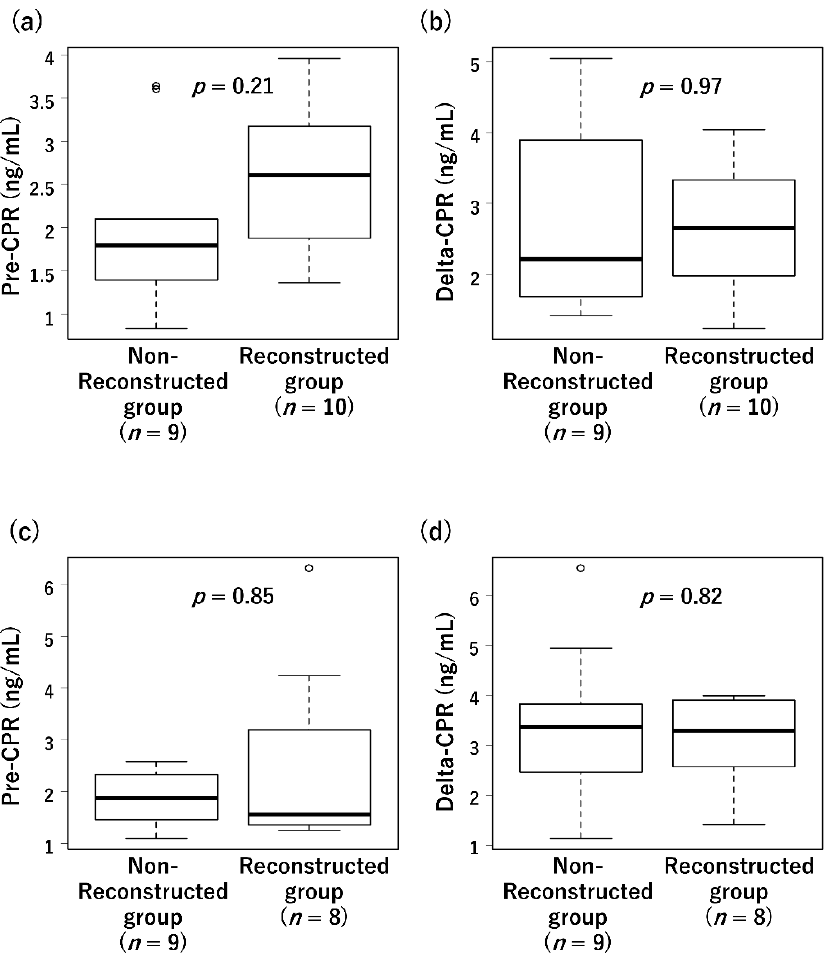
Figure 5. Results of glucagon stimulation test. ( a ) Pre-load C-peptide (CPR) at 1 month after transplantation: Pre-load CPR was lower in non-reconstructed group but not significantly different (the non-reconstructed group vs. the reconstructed group; 1.79 (1.39–2.10) vs. 2.61 (2.00–3.10), p = 0.211). ( b ) Delta-CPR at 1 month after transplantation: Delta-CPR of both the groups were comparable (the non-reconstructed group vs. the reconstructed group; 2.21 (1.68–3.89) vs. 2.65 (2.10– 3.27), p = 0.968). ( c ) Pre-load CPR at 1 year after transplantation: Pre-load CPR was not signifi-